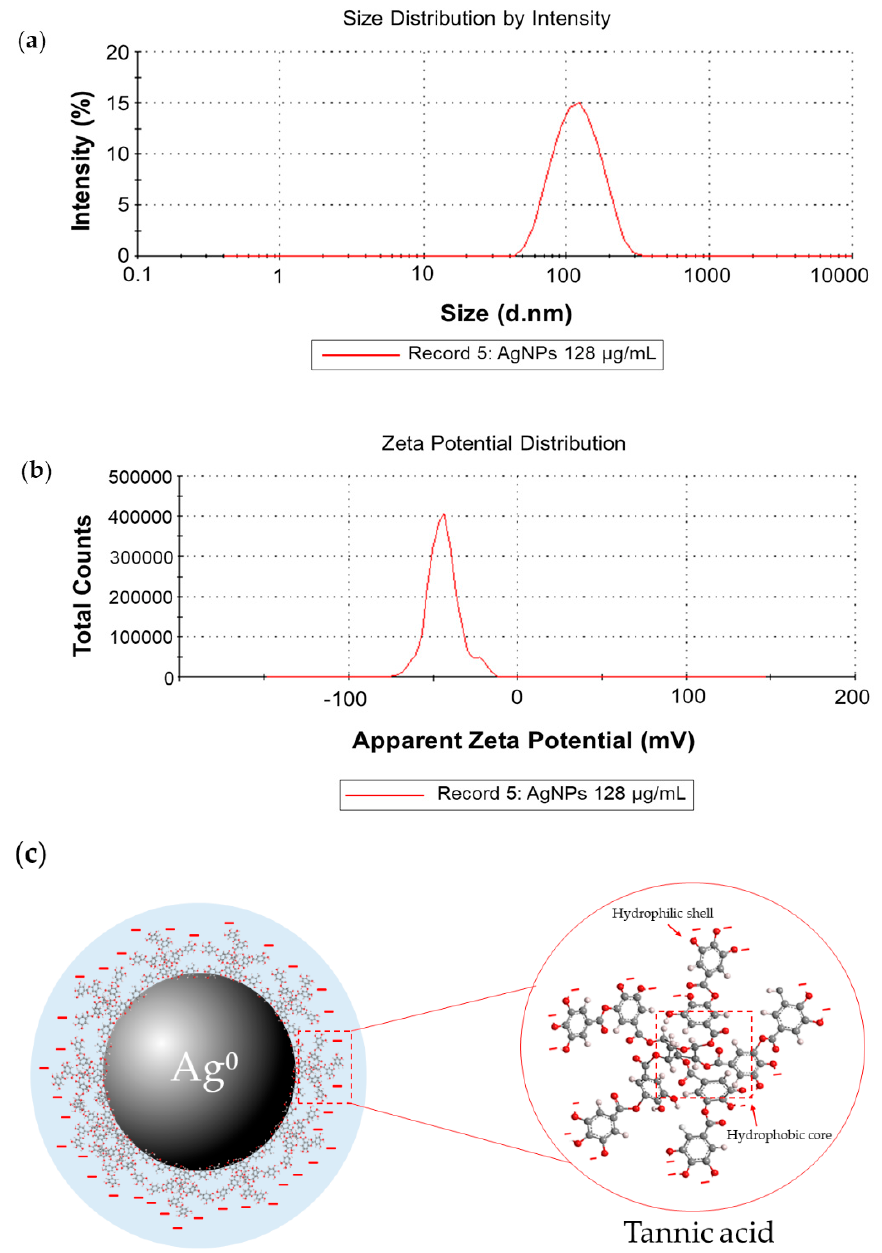
Figure 2. Dynamic Light Scattering (DLS) measurement of silver nanoparticles (AgNPs): ( a ) size distribution graph of AgNPs at 101.13 ± 0.85 nm; ( b ) and zeta potential of AgNPs at -47.63 ± 5.79 mV; ( c ) the simple structural model of tannic acid stabilized AgNPs molecules (pH = 5.94).